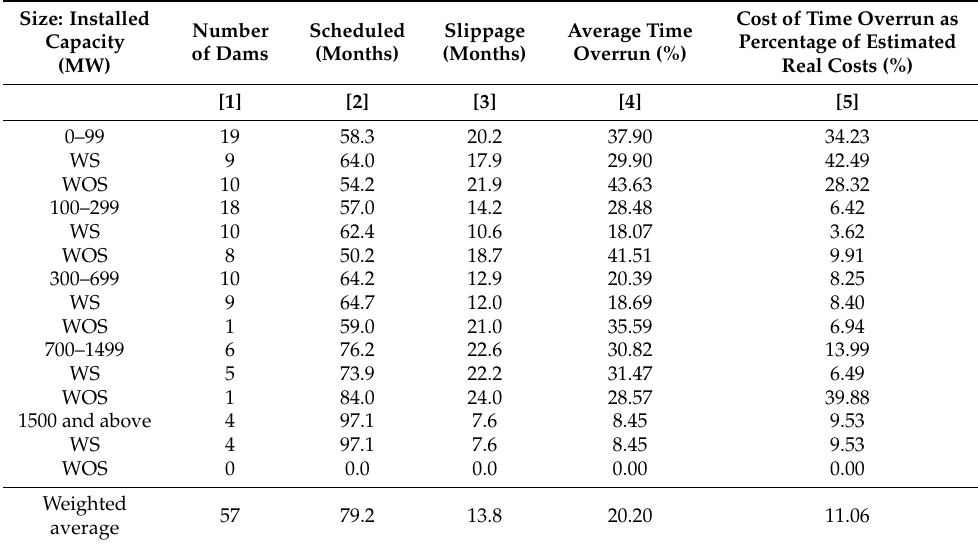
Table 9. Distribution of the cost of time overrun by size.